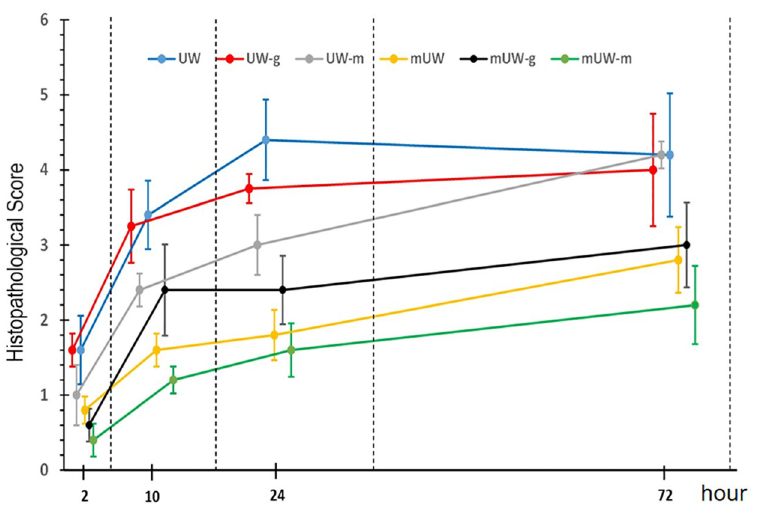
Fig 5. Microscopic score damage of kidney tissue at different time. Data are given as mean ±